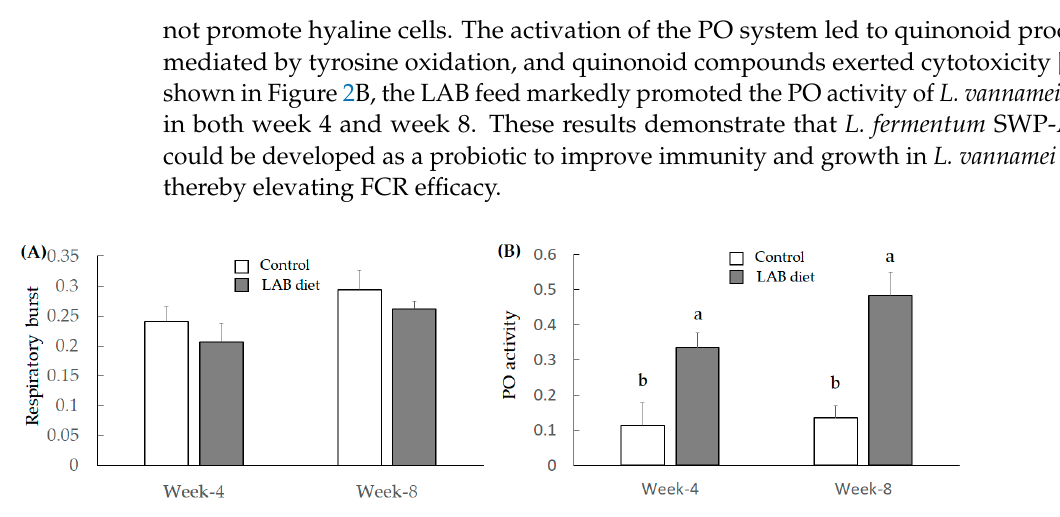
Figure 2. The regulation of LAB feed on respiratory burst (index of hyaline cell) ( A ) and PO activity (granular cells) ( B ). Significant difference is shown by different letters (a, b) ( p < 0.05) between control and LAB feed groups.